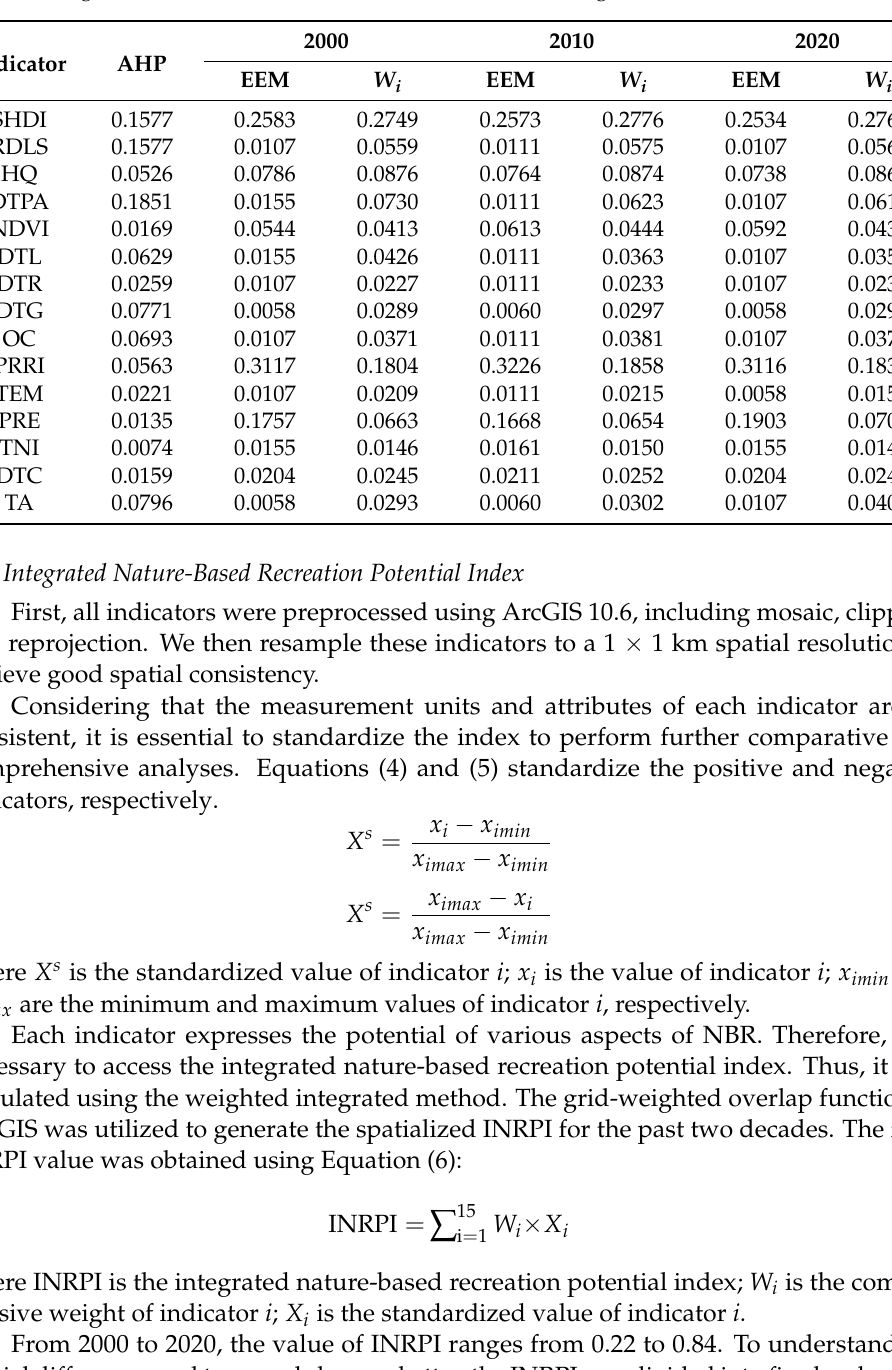
Table 2. Weight of evaluation indicator of NBR in the QTP during